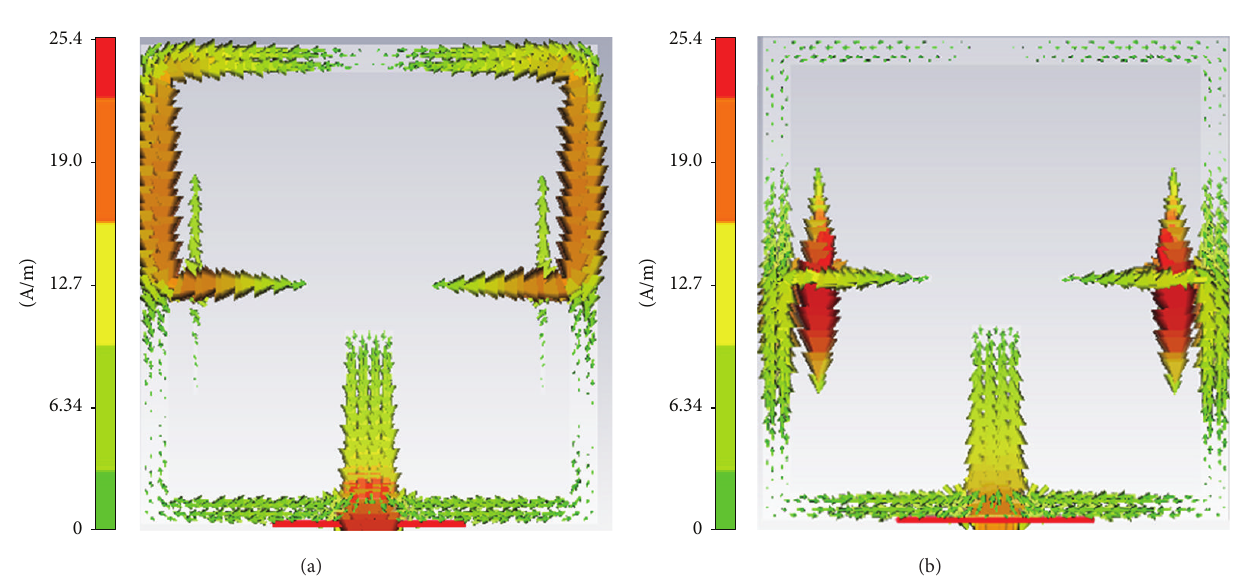
Figure 4: Surface current distribution (a) 3.5GHz and (b)